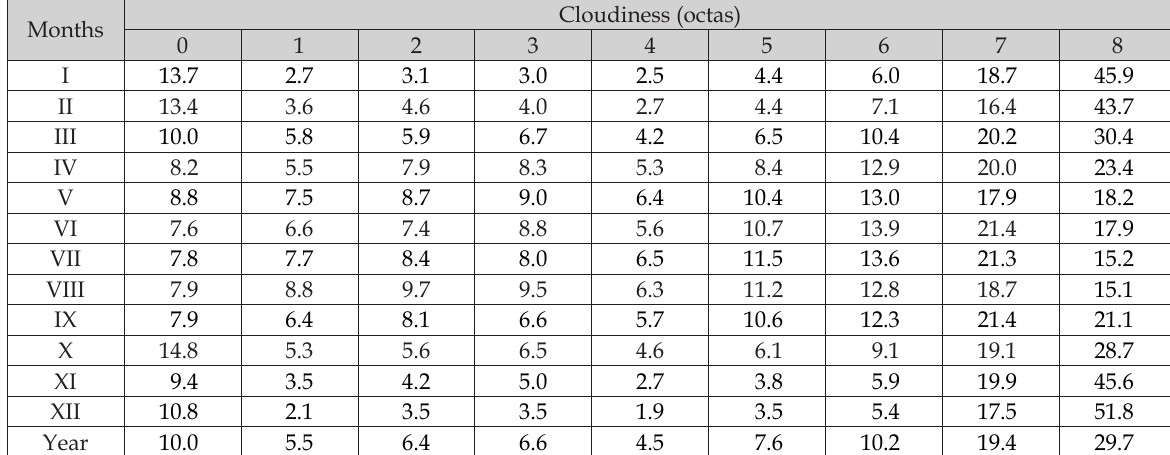
Table 2. Frequency of occurrence (%) of cloud cover in Poznań (1966–1998).